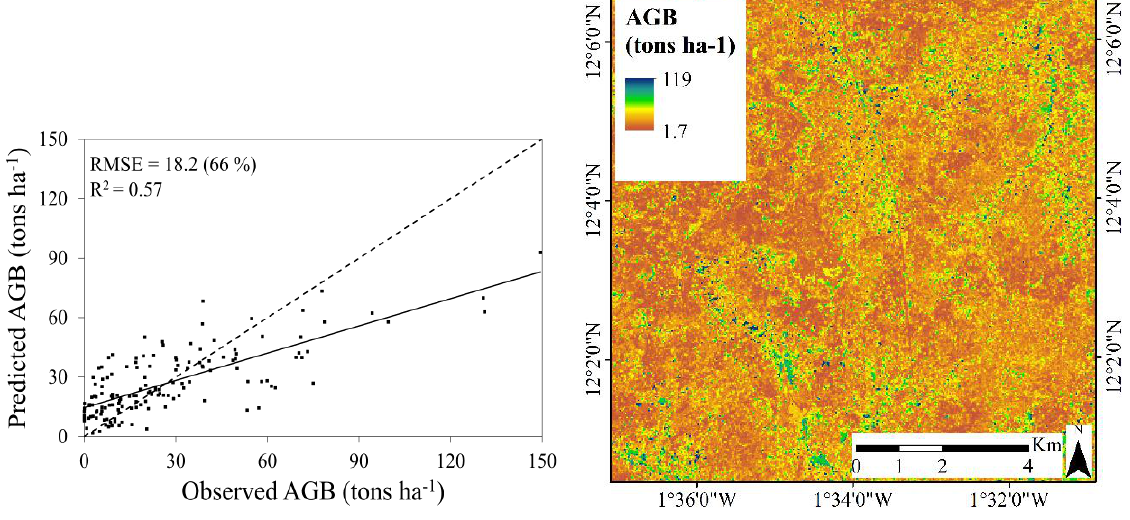
Figure 7. Relationship between observed and predicted aboveground biomass (AGB) using multi-temporal imagery and RF variable selection. The dashed 1:1 line shows an optimal model fit. The map of AGB to the right was derived from the most accurate model ( i.e. , multi-temporal imagery and reduced